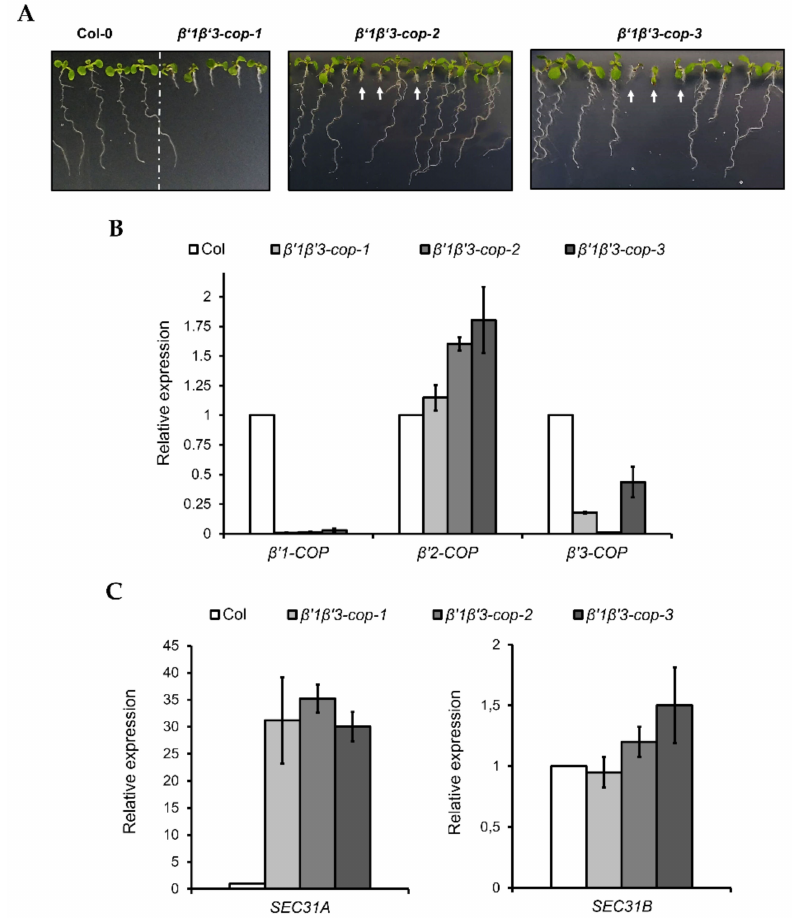
Figure 3. Characterization of β ’1 β ’3-cop double mutants. ( A ) All the β ’1 β ’3-cop homozygous double mutants show a dwarf phenotype at 7-day-old seedling stage. At later stages, the β ’1 β ’3-cop-1 mutant also showed a dwarf phenotype with smaller rosette leaves, shorter stems and roots and reduced fertility (Supplementary Figure S3). No homozygous lines could be obtained of β ’1 β ’3-cop-2 and β ’1 β ’3-cop-3 mutants as they were only viable as seedlings and failed to develop beyond the seedling stage. White arrows point β ’1 β ’3-cop-2 and β ’1 β ’3-cop-3 homozygous seedlings obtained from seeds of β ’1-cop-1 / β ’1-COP β ’3-cop-2 / β ’3-cop-2 plants and β ’1-cop-1 / β ’1-cop-1 β ’3-COP / β ’3-cop-3 plants, respectively. ( B ) RT–qPCR analysis show the expression levels of the three β ’-COP genes in β ’1 β ’3-cop double mutants relative to the wild type (Col-0). ( C ) β ’1 β ’3-cop-1 , β ’1 β ’3-cop-2 and β ’1 β ’3-cop -3 mutants show upregulation of the COPII subunit SEC31A gene. Expression of SEC31A and SEC31B was analyzed by RT–qPCR. Total RNA was extracted from 7-day-old seedlings of wild type (Col-0) and homozygous mutants ( β ’1 β ’3-cop-2 and β ’1 β ’3-cop-3 were selected by size). The mRNA was analyzed by RT–qPCR with specific primers and normalized to UBQ10 expression (Supplementary Tables S1–S3). Results are from three biological samples and three technical replicates. mRNA levels are expressed as relative expression levels and represent fold changes of mutant over wild type. Values represent mean ± s.e.m. of the three biological